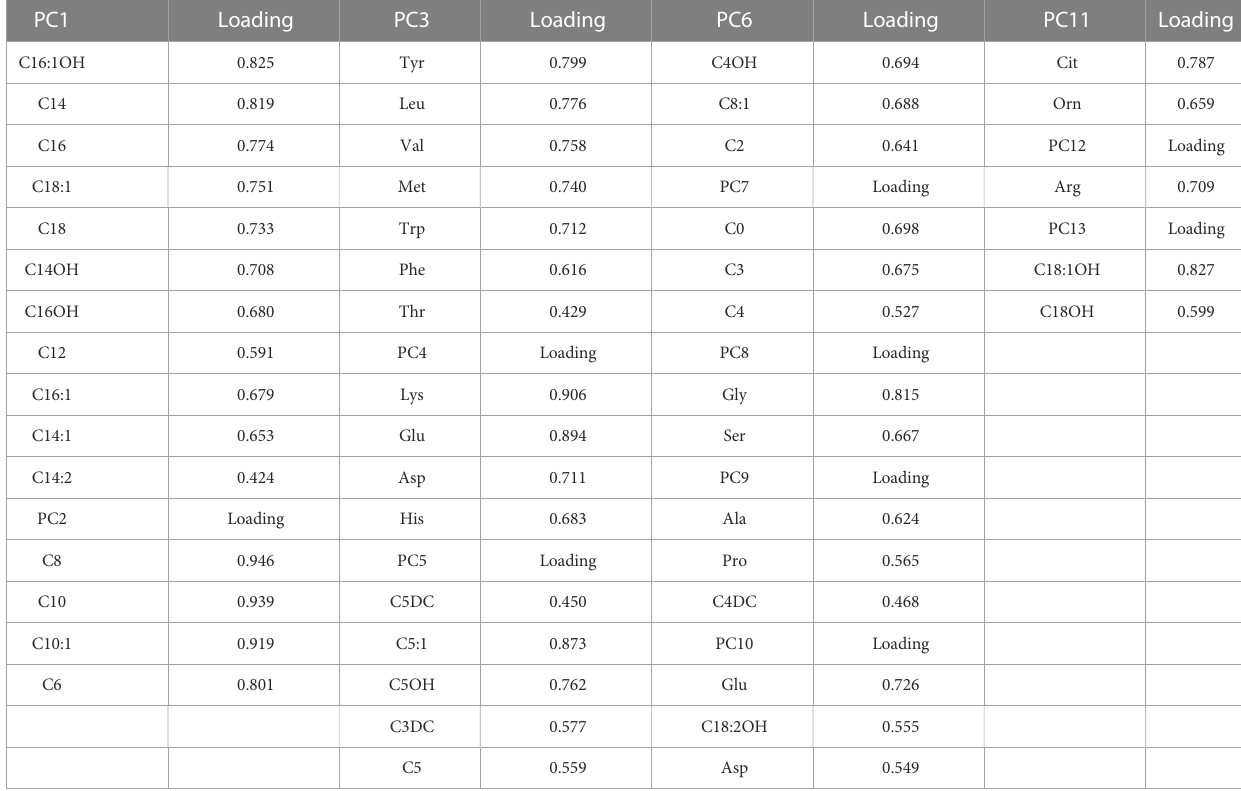
TABLE 3 Extracted factors based on PCA and loadings.